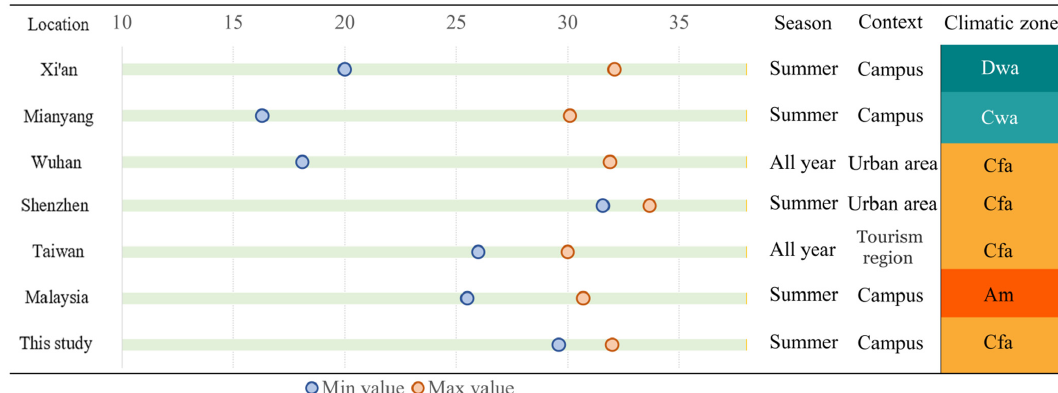
Figure 6. A comparison of neutral PET ranges in different areas. (Dwa: monsoon-influenced hot- summer humid continental climate; Cwa: monsoon-influenced humid subtropical climate; Cfa: hu- mid subtropical climates; Am: tropical monsoon climate).